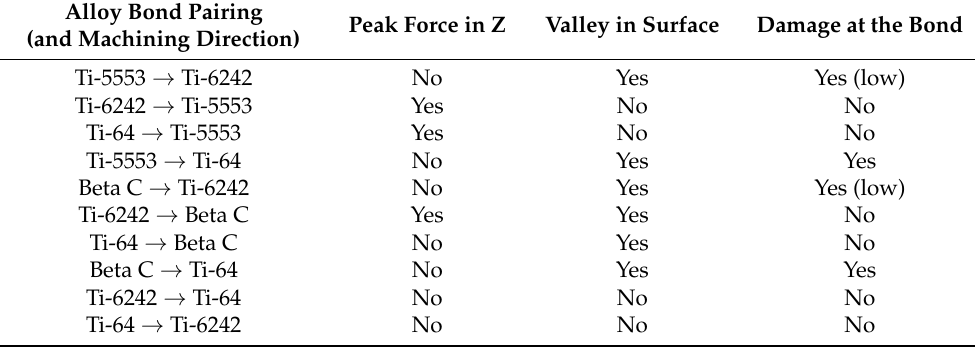
Table 4. Summary of the findings in the multiple diffusion bonds studied in this work after being machined. Alloy Bond